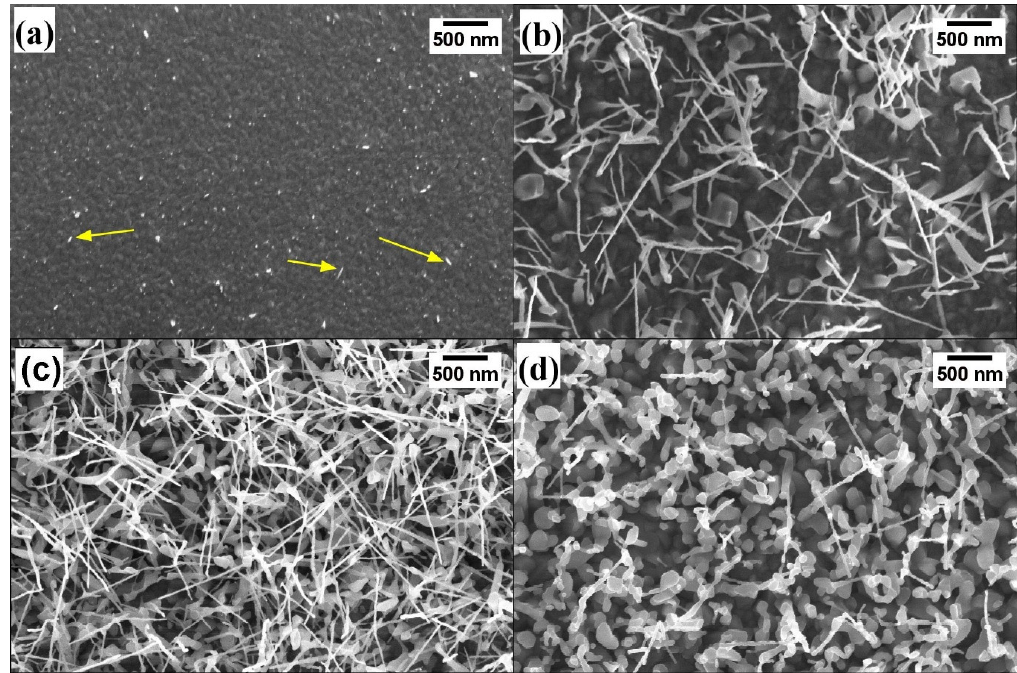
Figure 4. SEM view of TiO 2 nanowires grown at different temperatures: ( a ) 600, ( b ) 650, ( c ) 700, and ( d ) 750 °C. Oxidation time was 3 h and the oxygen and Ar flow was set 10 and 100 SCCM, respectively.